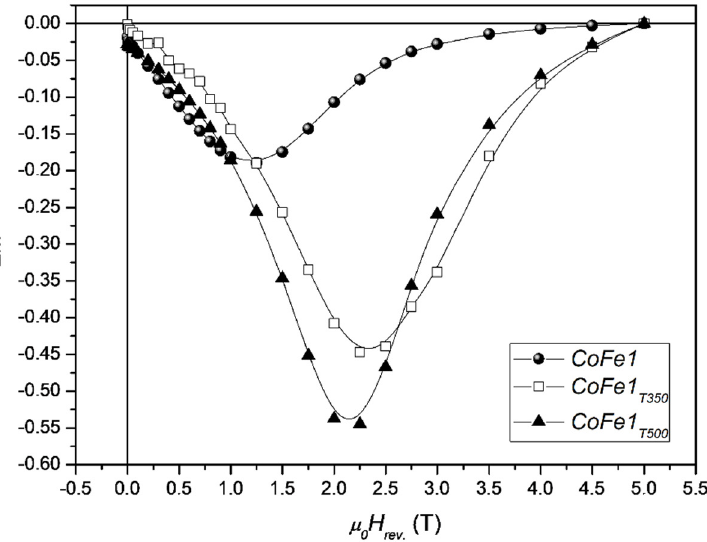
Figure 6. ∆ M plot at 5 K for the CoFe1 (full circles), CoFe1T350 (empty squares), and CoFe1T500 (full triangles) samples. The figure is reproduced with permission from ref. [37].